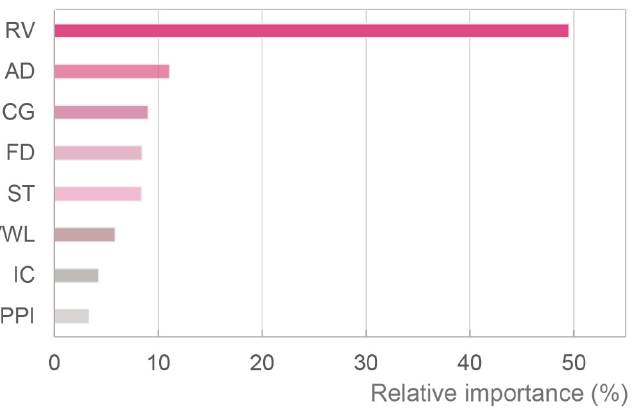
Figure 13. The relative importance of disaster-causing factors in the RO-PSO-SVC model. The relative importance is normalized so that they sum to 1.